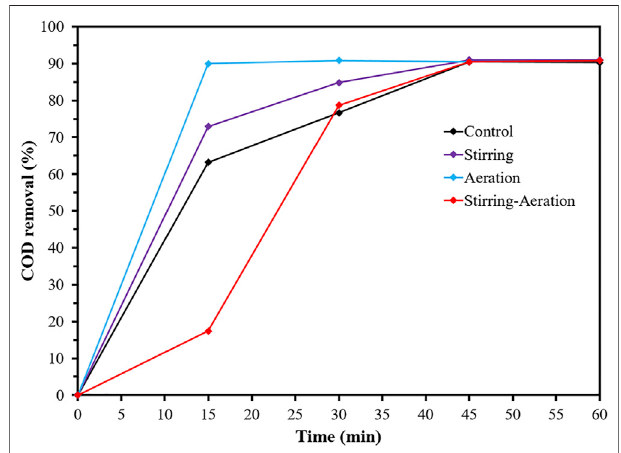
FIGURE 1 | COD removal ef fi ciency of different EC systems.